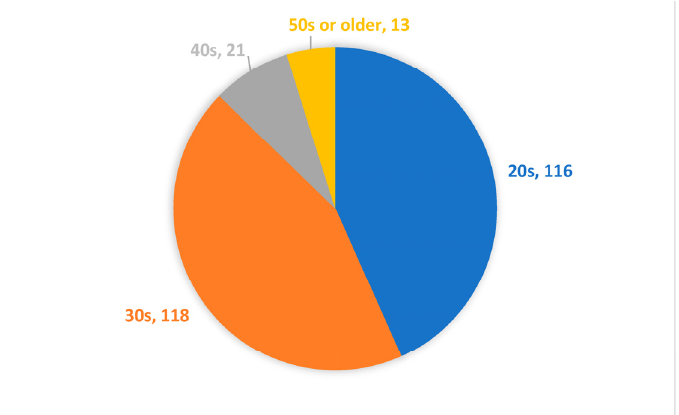
Figure 3. Distribution of age (numbers in figure represent an actual number of test subjects in each group).